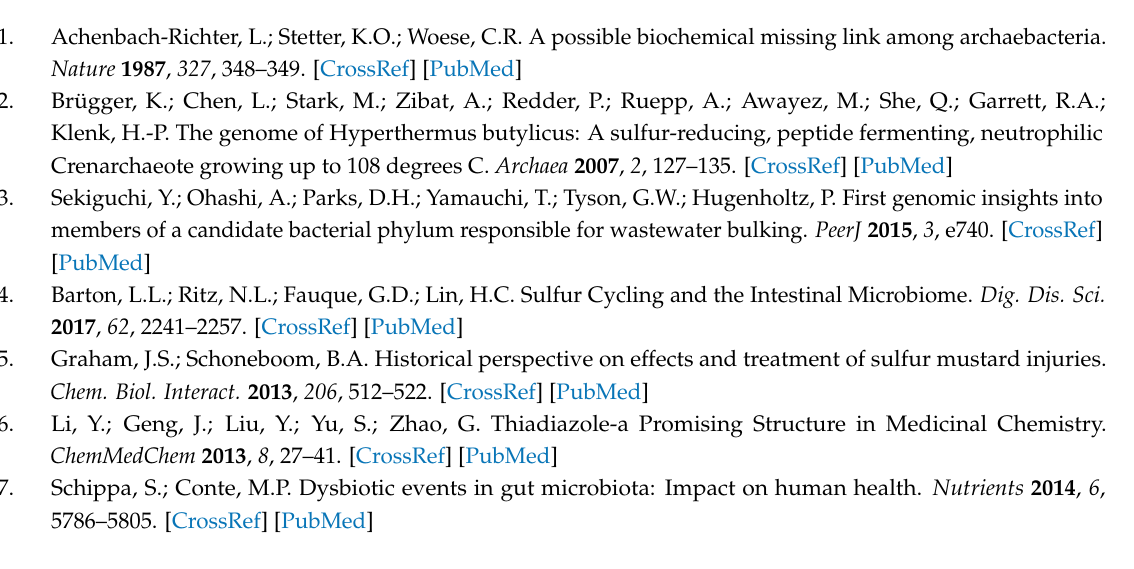
Supplementary Materials: The following are available online: Figure S1: AKs in closed conformations docked with derivative 1c ; Figure S2: AKs in closed conformation docked with derivative 1d ; Table S1: Comparison Table S2: The interactions of 1c with selected AKs; Table S3: The interactions of 1d with selected AKs; Table S4: The characterization of 5-arylidene-2-thioxothiazolidin-4-one derivatives; Table S5: The main characteristics of the AKs used in protein-ligand